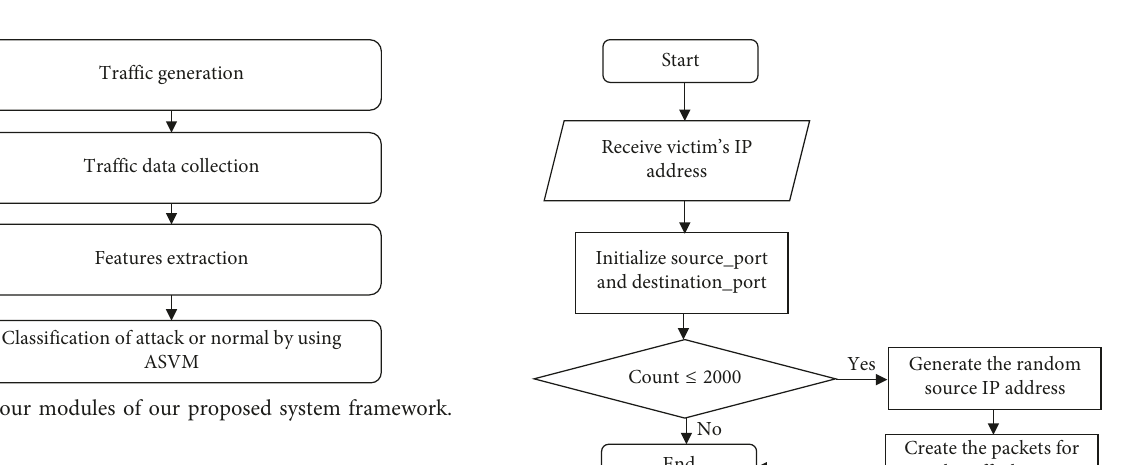
Figure 2: The proposed SDN-based DDoS attack detection framework.